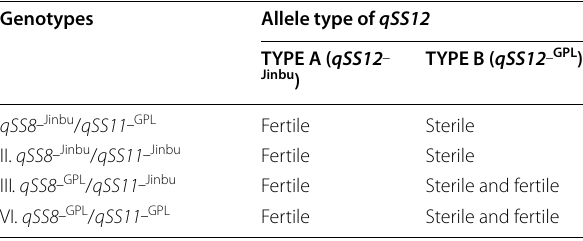
Table 3 Spikelet fertility of the tested lines using the combinations of the three QTLs based on allele types detected from the